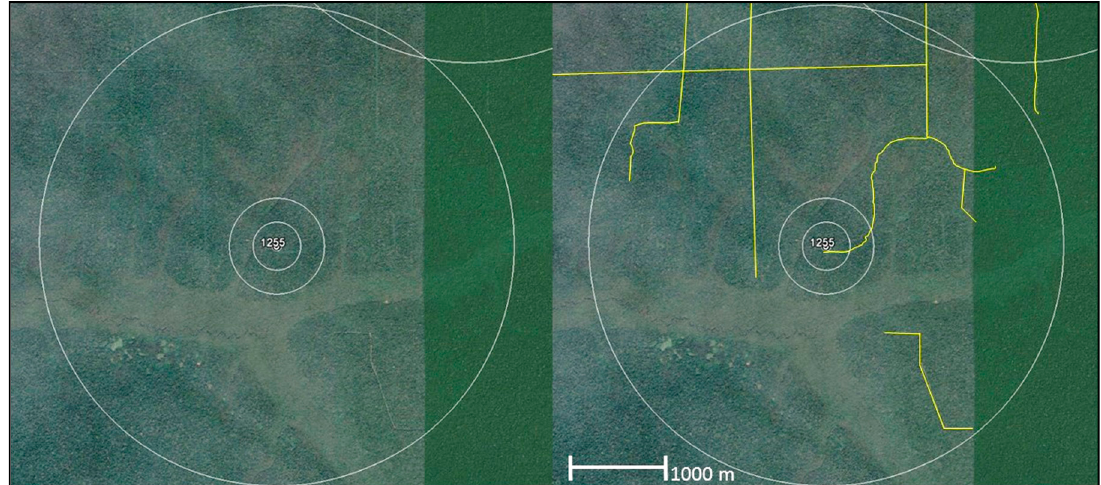
Figure 9. Point 1255 is secondary forest, on an old logging road that has regrown, the network of abandoned logging roads is highlighted on the right for illustration (1°53 ′ 47.77 ″ N, 21°58 ′ 36.09 ″ E).